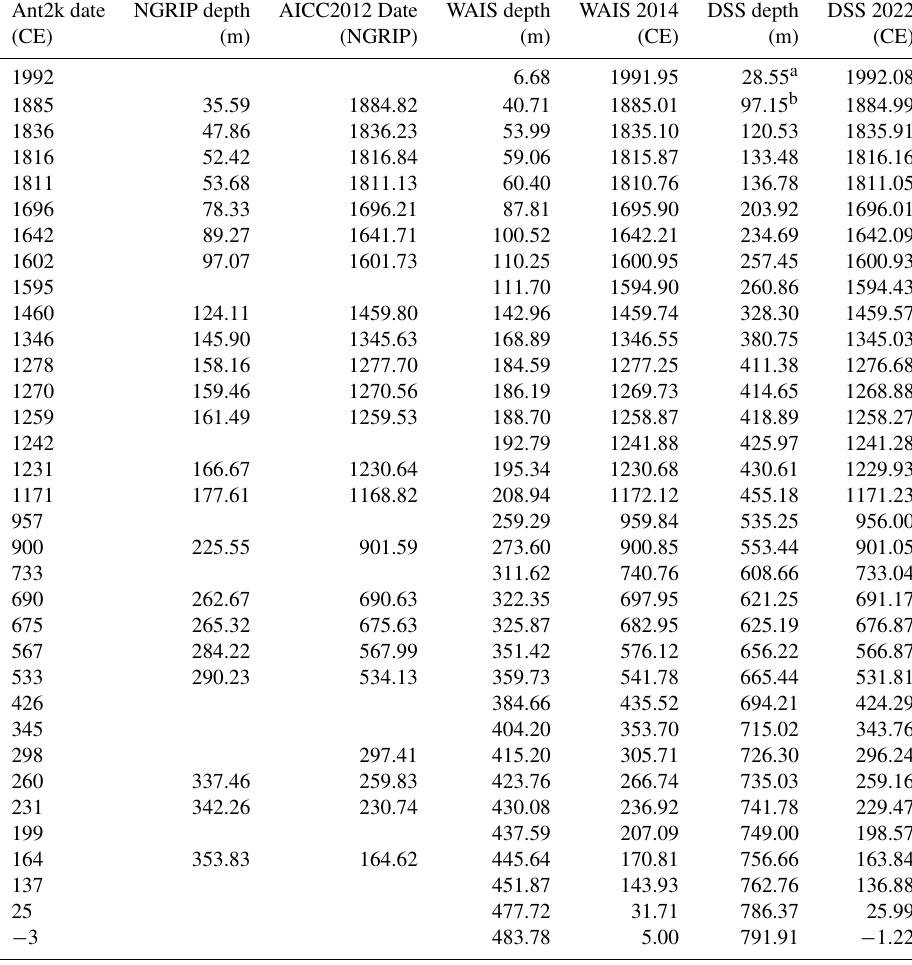
Table A1. Synchronisation of the Law Dome ice core chronology to other commonly used ice core chronologies. Ant2k dates are those already published by Ahmed et al. (2013) using the mean date of the event peak in WAIS, NGRIP and DSS cores. To determine the AICC2012 date, DSS is matched to NGRIP and selected as it has the highest resolution, though fewer ties can be matched. All depths referred to in the DSS2022 chronology are from the DSSMain core except for those marked a which indicates DSS1617 and b where DSS99 is